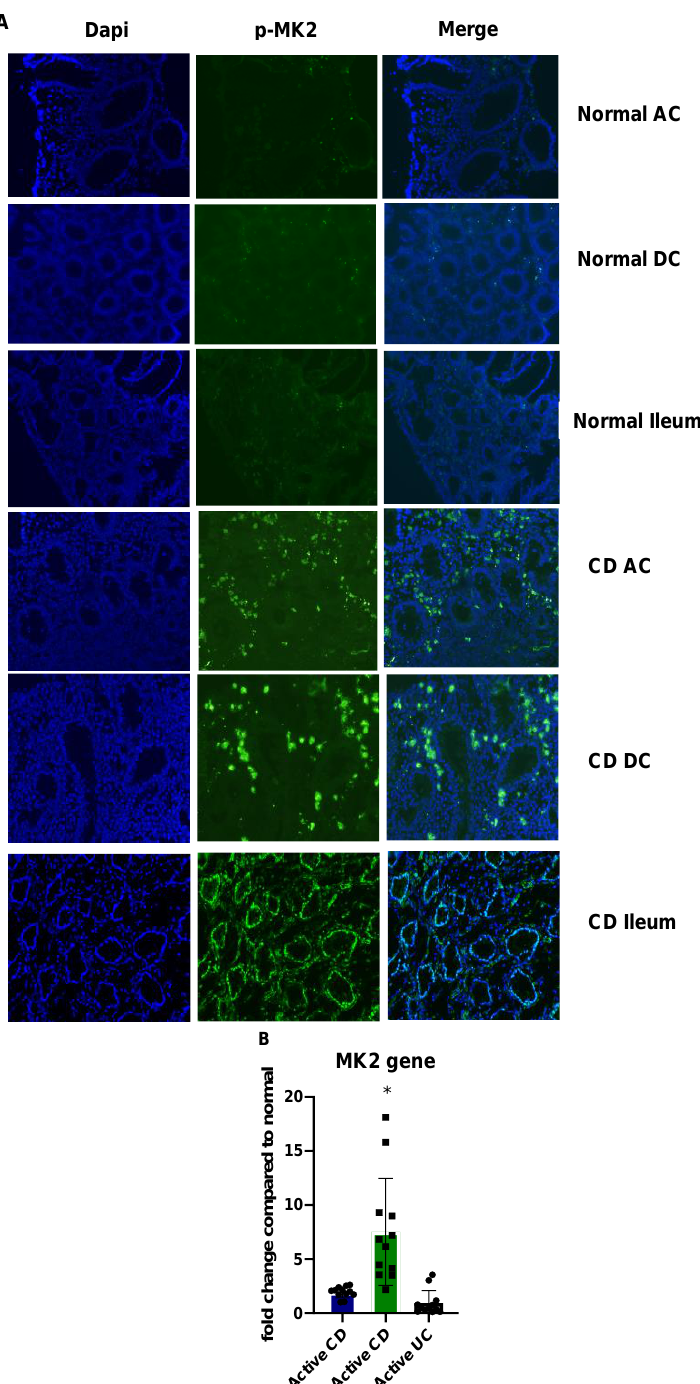
Figure 1. MK2 expression and activity are increased in CD tissues where ( A ) biopsies stained for p-MK2 show drastically increased staining in CD tissues compared to normal tissues and ( B ) MK2 gene expression is increased slightly in non-active CD tissues and much higher in active CD tissues, but not increased in active UC tissues. N = 12 for gene expression, * p <